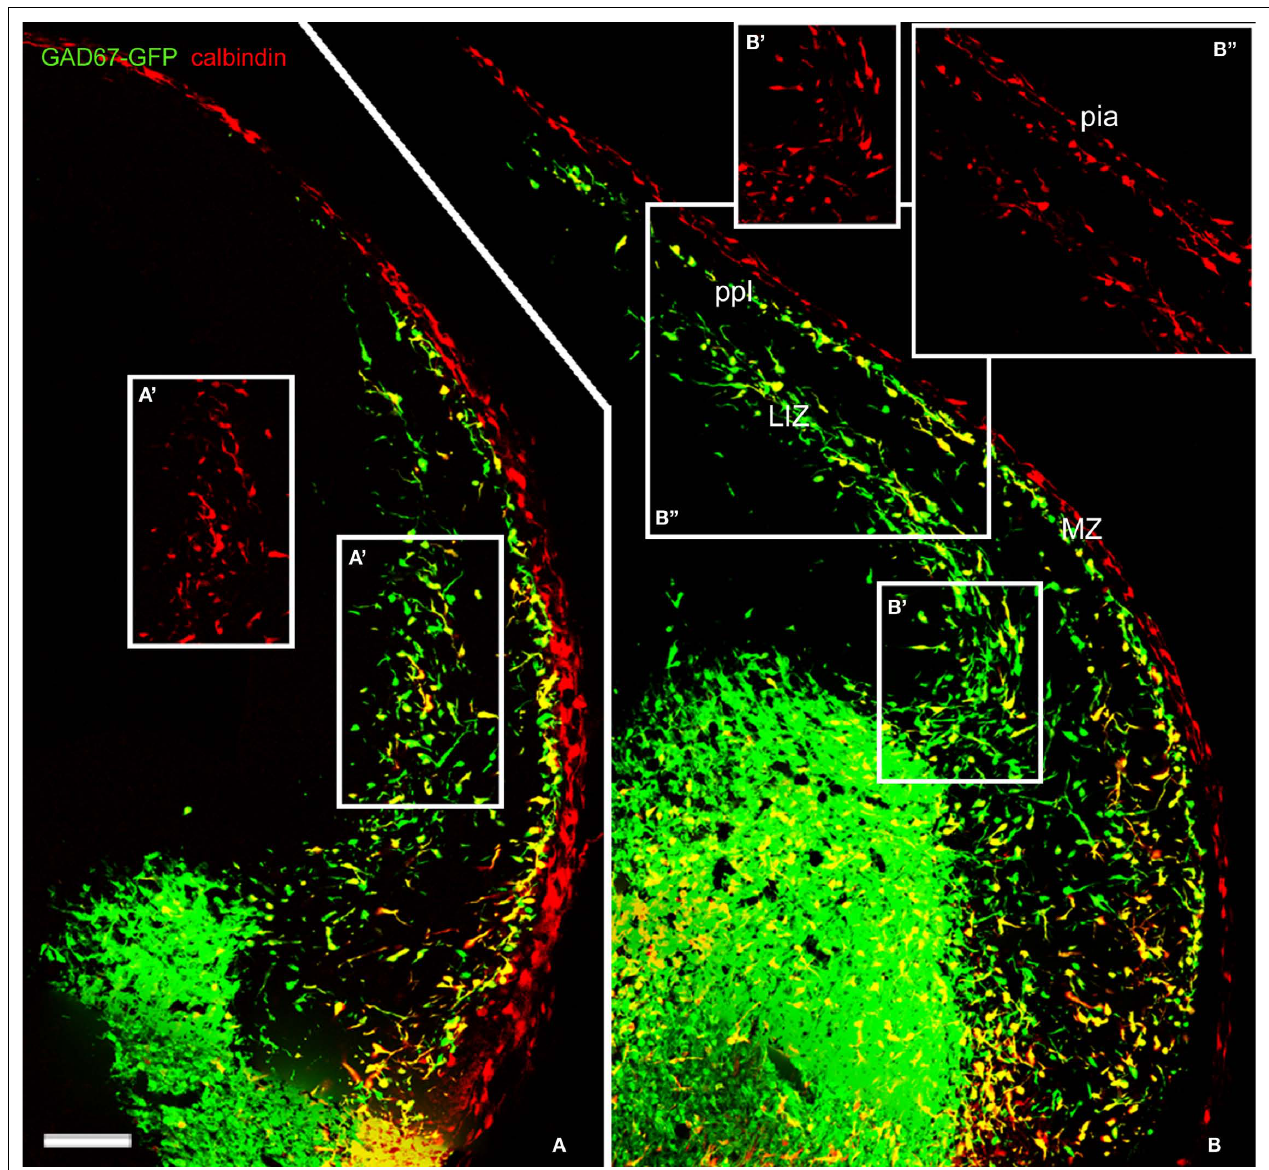
FIGURE 2 | Calbindin labeled migratory GABAergic interneurons in the E13.5 mouse preplate. Migratory interneurons, labeled by GAD67 promoter-driven GFP expression, were seen to leave the ventral forebrain in their way to the pallium, following well-defi ned migratory pathways at rostral (A) and more caudal levels (B) . CB immunoreactivity co-localized with EGFP in only part of the GAD67-GFP